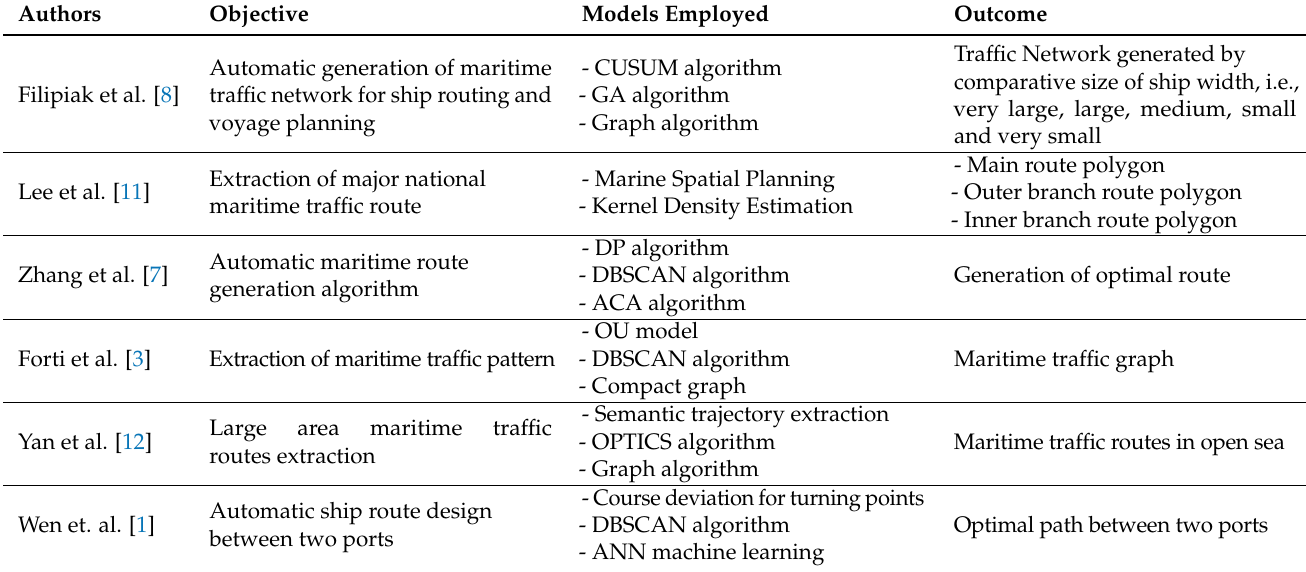
Table 1. A summary of the approaches to ship route extraction by various authors.